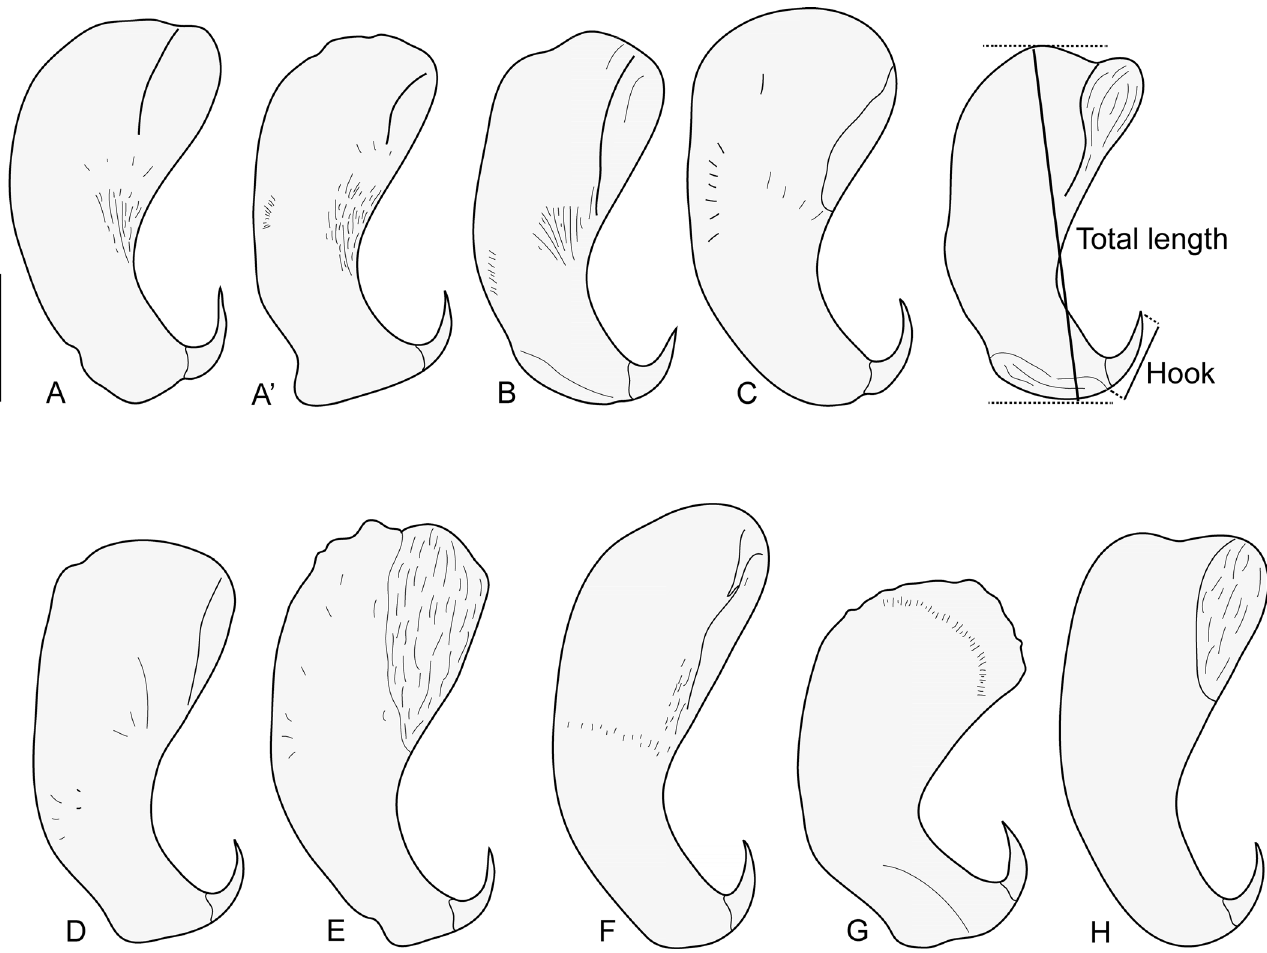
Figure 3. Indopolystoma viridi n. gen. n. sp. from Zhangixalus viridis . Hamuli from holotype and paratypes. (A – A ’ ) Holotype; (B – H) Paratypes. Scale bar: 100 l